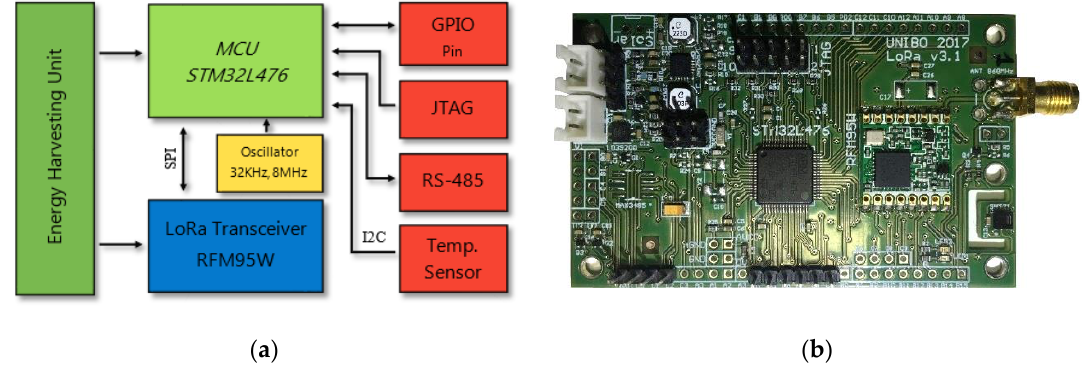
Figure 10. End device HW. ( a ) Hardware block diagram; ( b ) picture of the custom board.